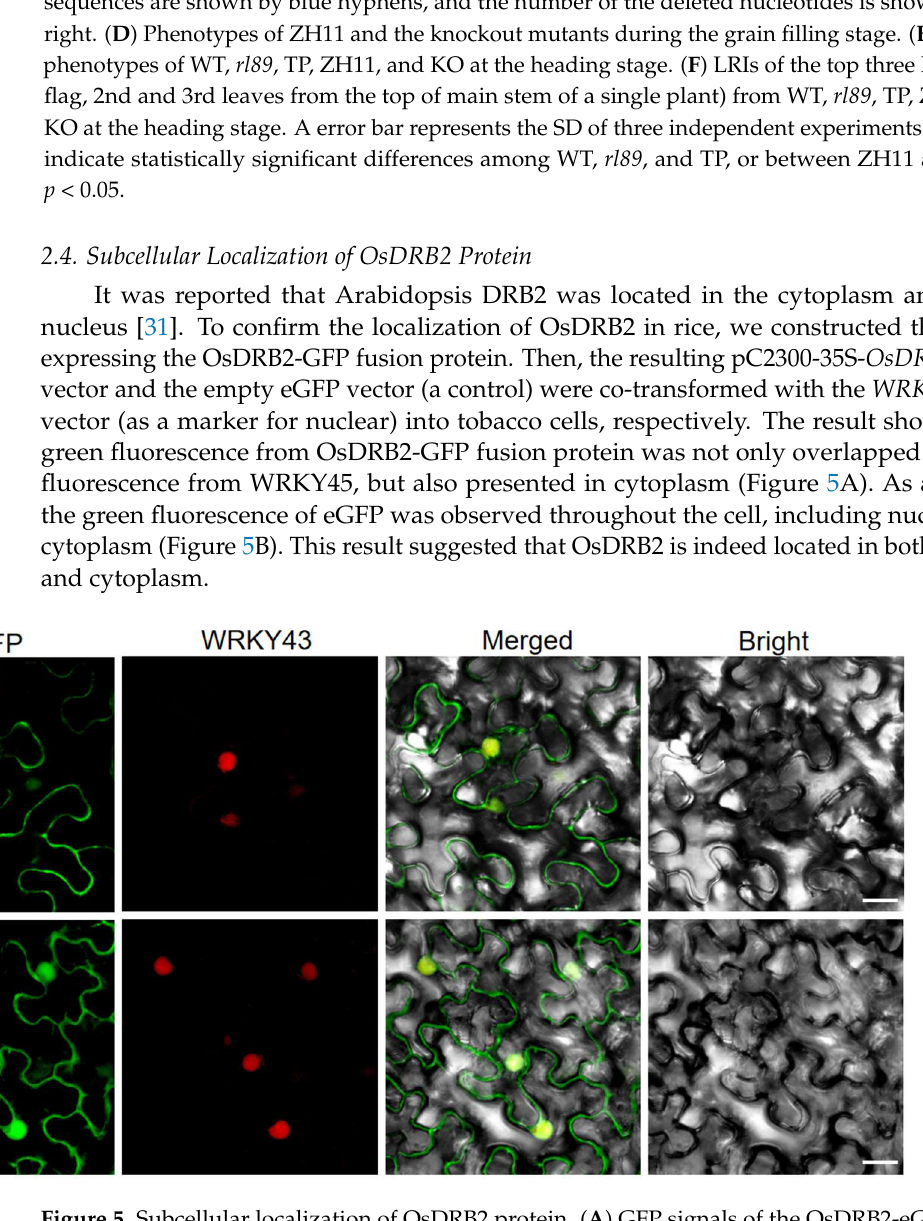
Figure 5. Subcellular localization of OsDRB2 protein. ( A ) GFP signals of the OsDRB2-eGFP fusion protein. ( B ) Empty vector eGFP without a specific targeting sequence. Green fluorescence shows GFP, red fluorescence indicates the fluorescence of nuclear marker gene WRKY45 , yellow fluorescence indicates images with the two types of fluorescence merged, and bright field images show tobacco cells. Fluorescence signals were visualized using a laser-scanning confocal microscopy. Bars = 20 μm.